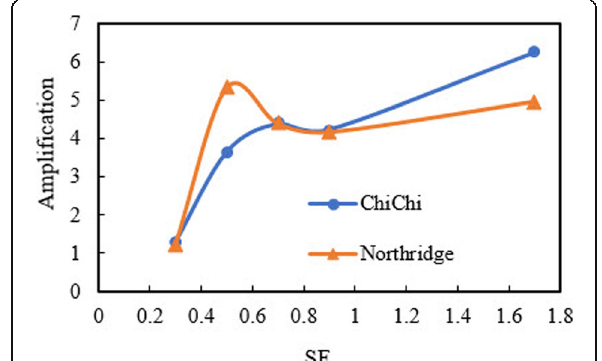
Fig. 9 Effect of SF on amplification of seismic input motion (Chi-Chi and Northridge)